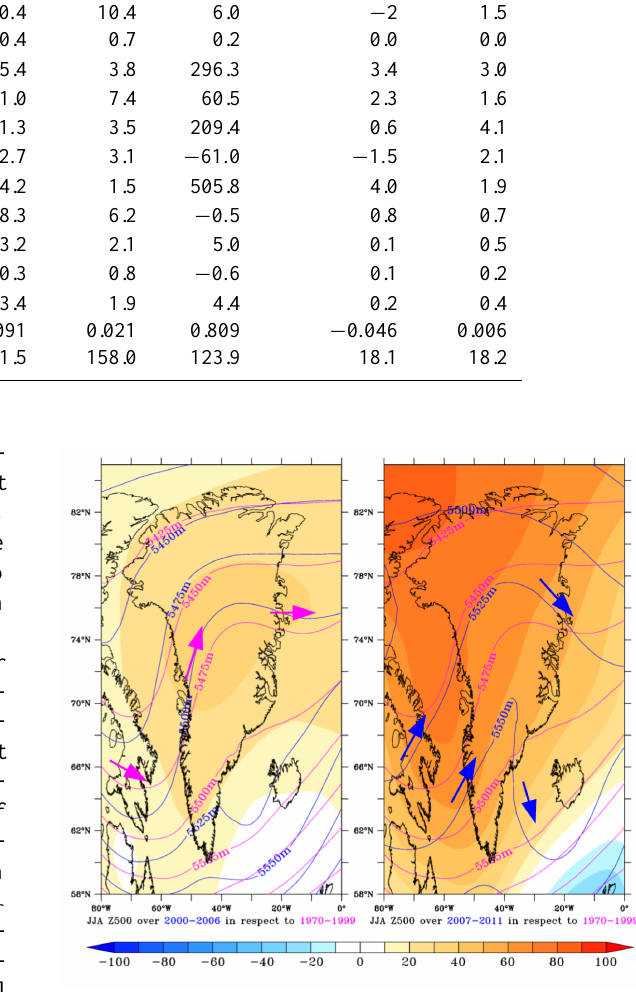
Fig. 9. The geopotential height anomalies for JJA 2000–2006 (a) and 2007–2011 (b) (referenced to the 1970–1999 average) at 500hPa from the NCEP/NCAR Reanalysis. The blue and respec- tively magenta lines illustrate the JJA average geopotential height at 500hPa in 2000–2006 and 2007–2011 and over 1970–1999. The arrows show the direction of the prevailing